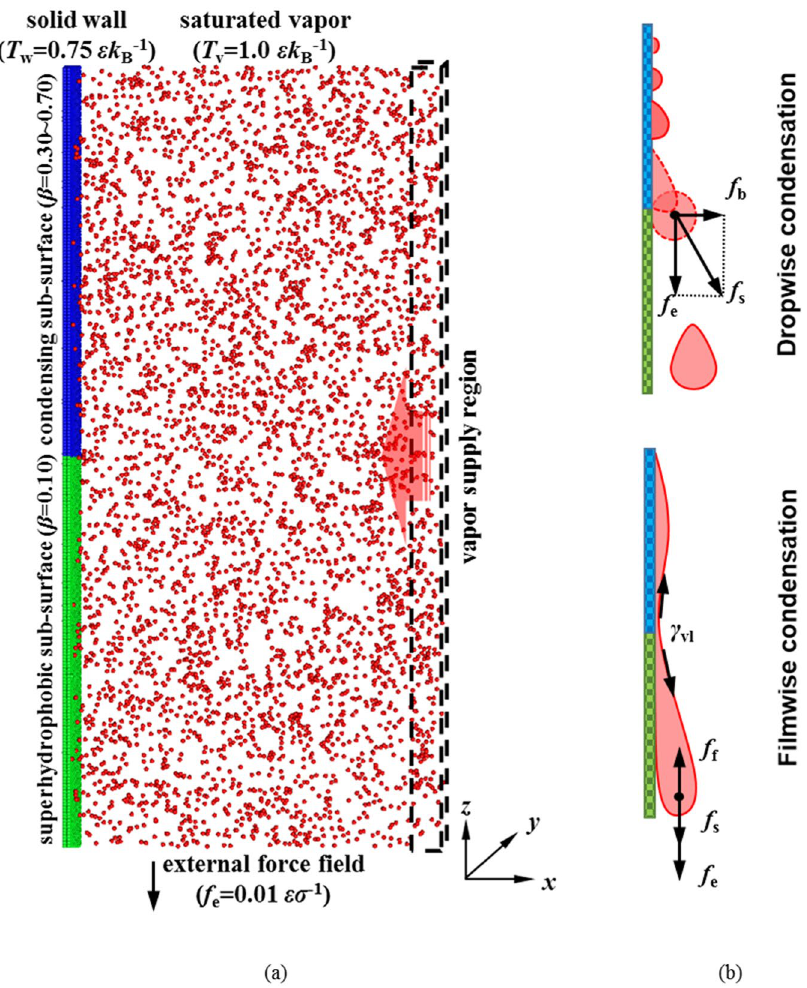
Figure 1. Schematic presentations of ( a ) computational model and ( b ) force analyses. The simulation size measures l x × l y × l z = 98.2 σ × 8.5 σ × 97.7 σ . The saturated vapor is at T k 1 0 1 ε = . − . The vaper supply region is rightmost and the solid wall is leftmost, which is comprised of at T k 0 75 w B condensing surface with β = 0.30~0.70 (blue) and superhydrophobic surface with β = 0.10 (green). The external force field is εσ = . − f 0 01